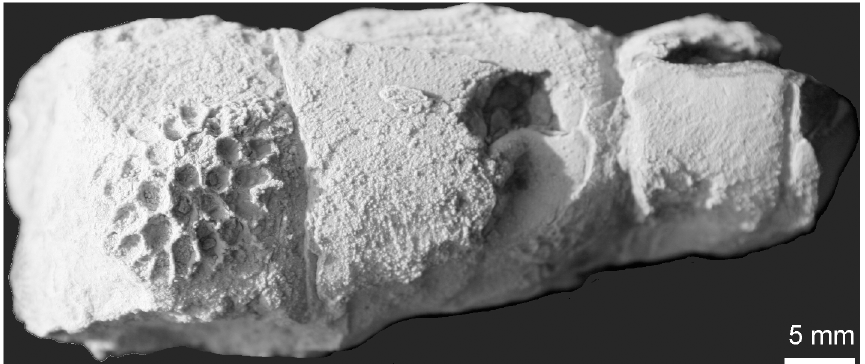
Fig 4. ? Favosites sp. 2 encrusting nautiloid, from Kowala Quarry, lithological set L, late Famennian. Specimen GIUS 3619 KF